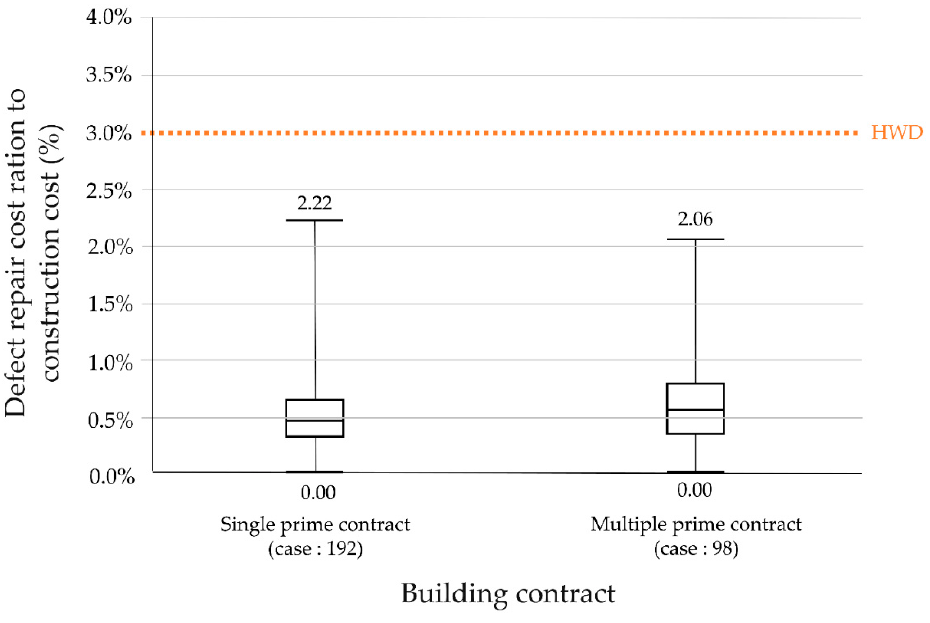
Figure 9. Comparison of building contract.